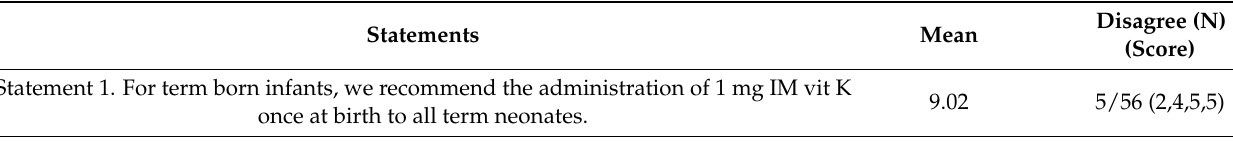
Table 6. Voting results (scores 0–10) on the statements on vitamin K